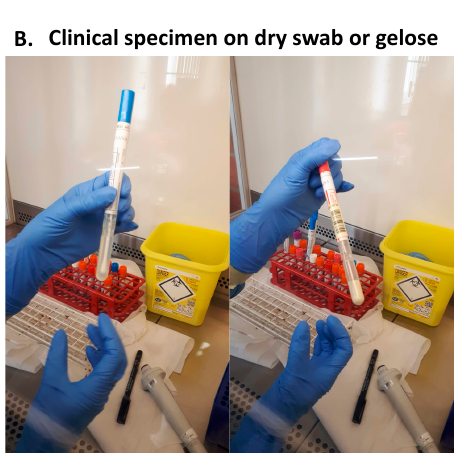
Figure 1. Type of clinical specimen tubes.